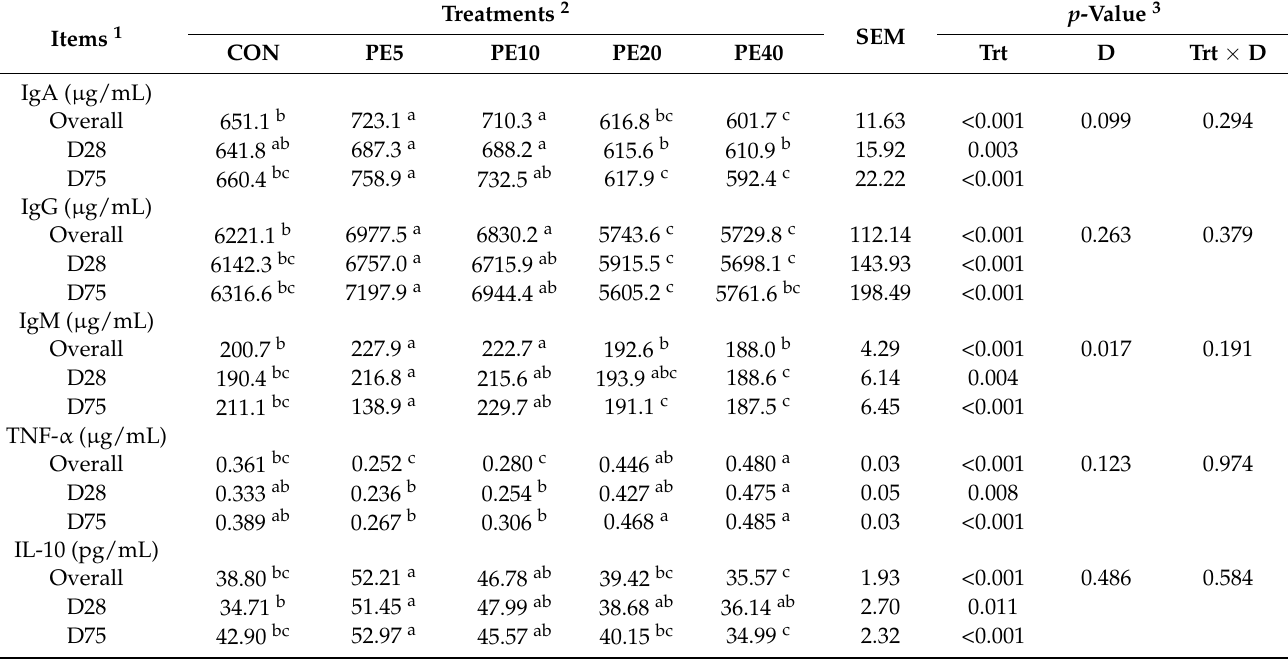
Table 2. Serum immunoglobulin and cytokines concentrations of calves supplemented with Amla ( Phyllanthus emblica ) whole-fruit